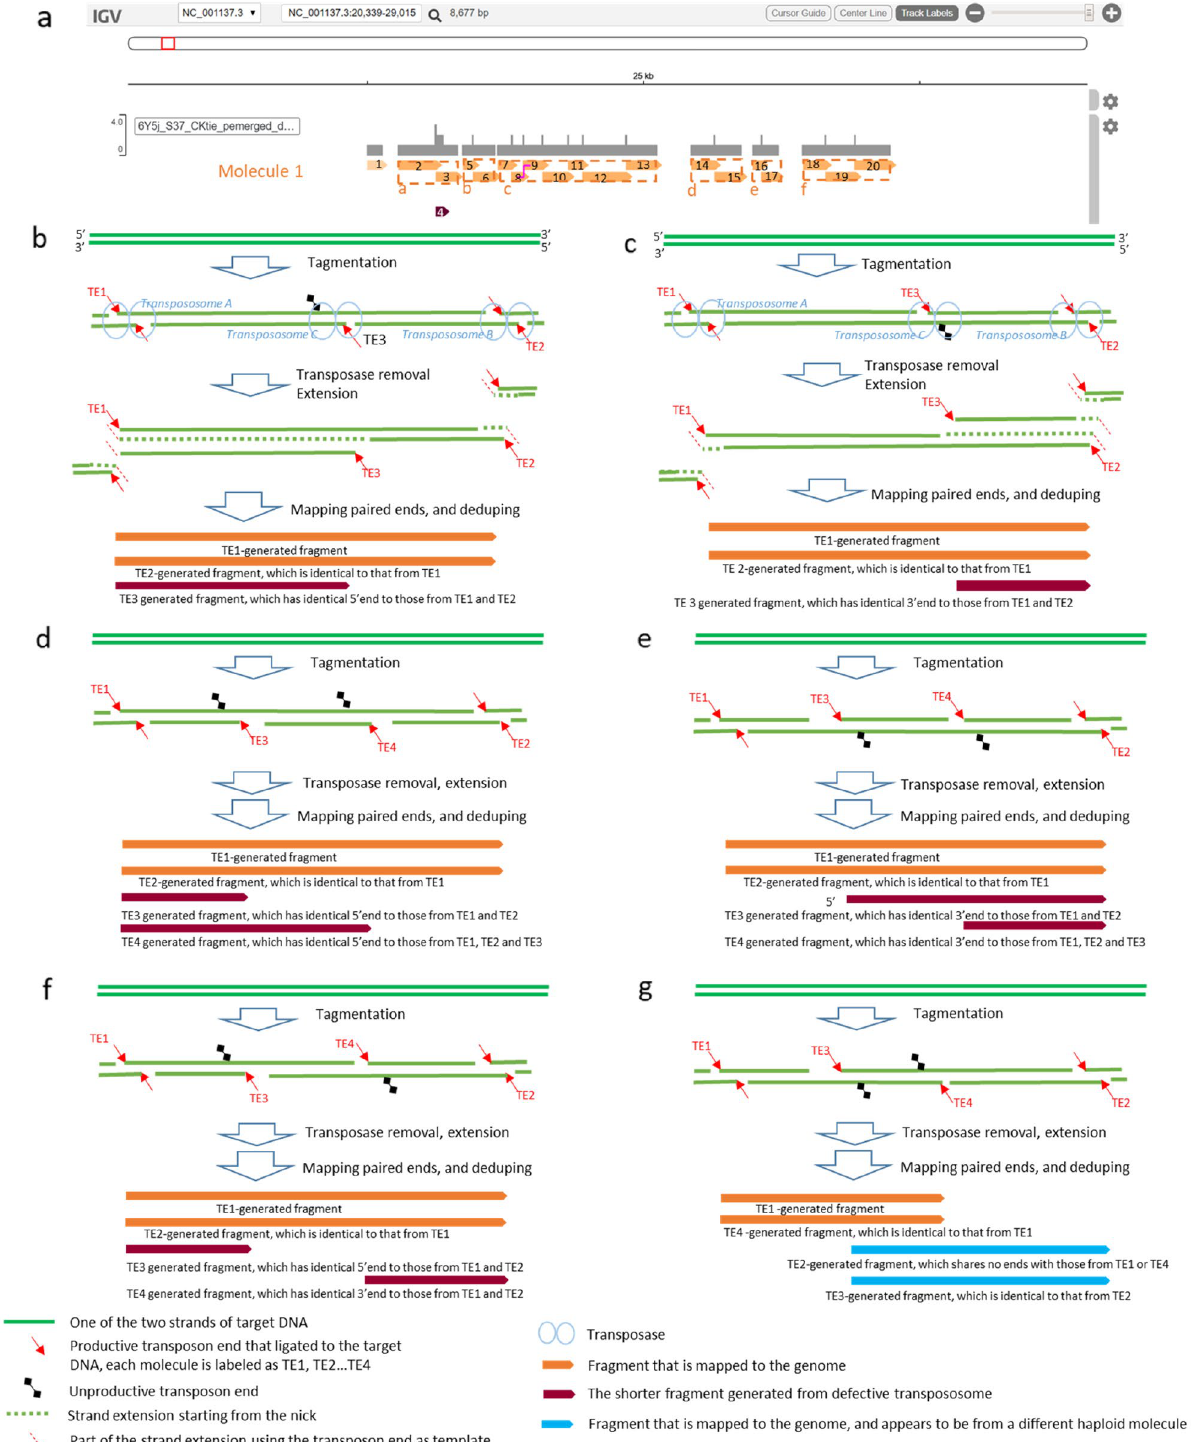
Figure 3. Defective transpososomes leads to artifacts. ( a ) Nineteen fragments in the archipelago of Chr V/ NC_001137.3 22,504 to 27,231 are reconstructed into one molecule. The seemingly lone Fragment 4 led to the discovery of defective transpososomes. ( b–g ) are Defective Scenarios 0/1, 1/0, and Complex Scenarios 00/11, 11/00, 01/1/0, and 10/01 respectively. The graphs were generated with Microsoft PowerPoint and IGV (https:// softw are. broad insti tute. org/ softw are/